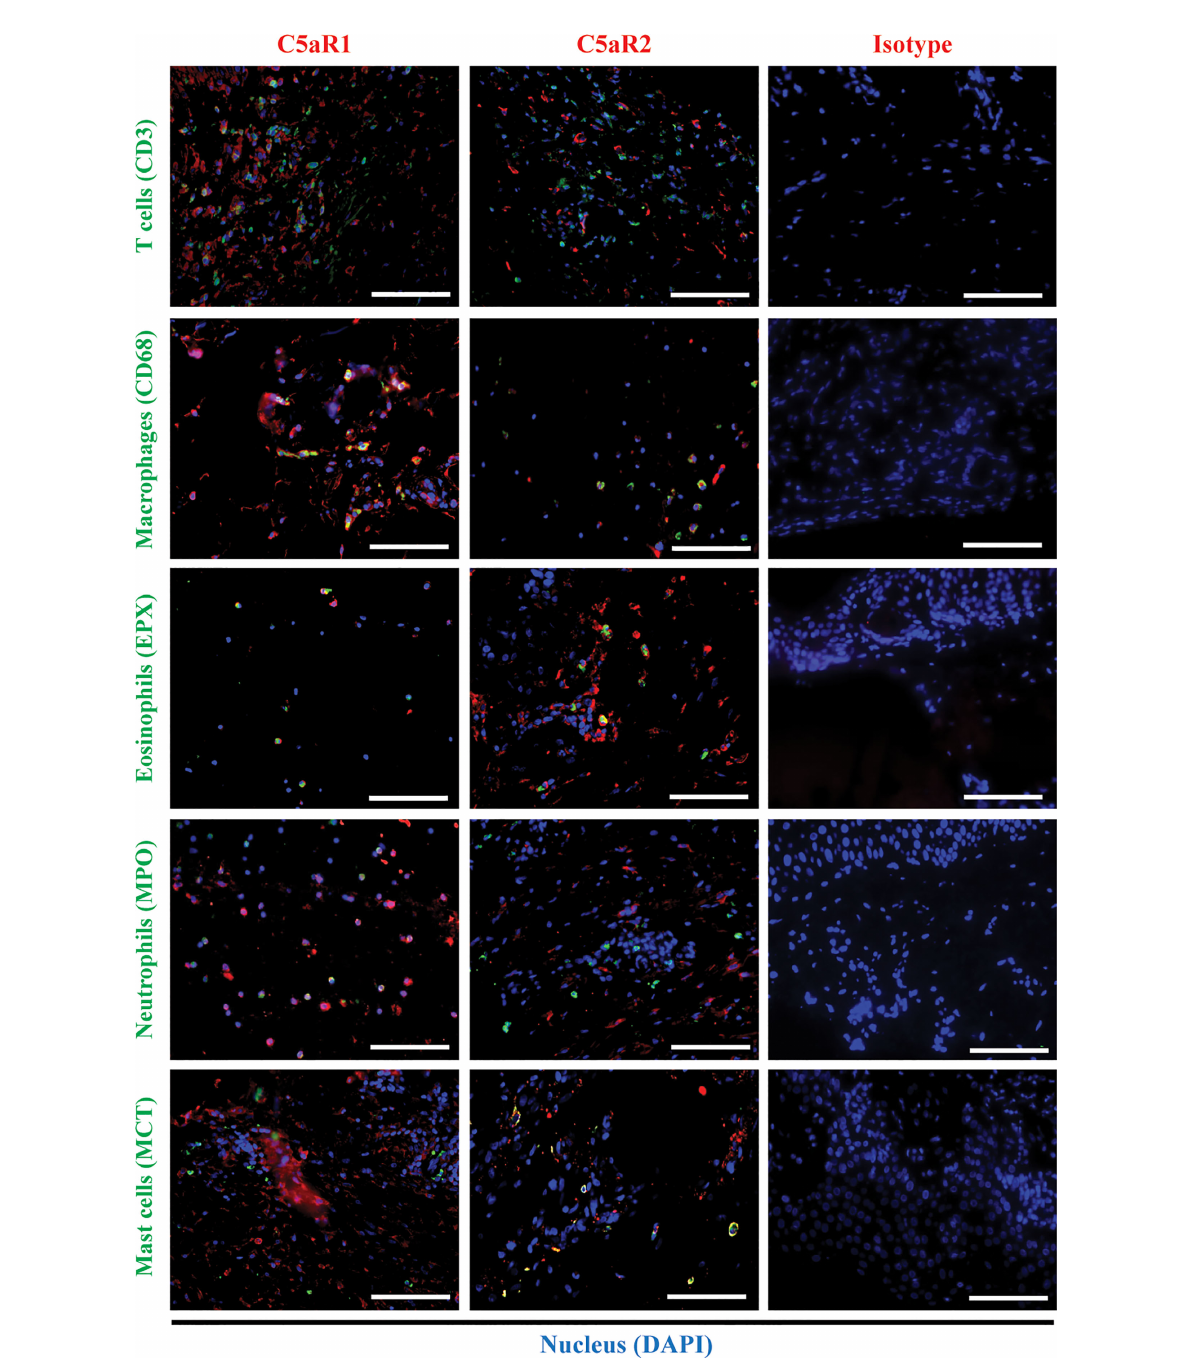
FIGURE 2 Double immuno fl uorescence (IF) staining revealed the cellular sources of C5aR1 and C5aR2 in early bullous pemphigoid (BP) skin lesions. IF staining on perilesional skin of BP patients (n=9) shows colocalization of C5aR1 (red) or C5aR2 (red) and cellular markers (green) on in fi ltrating T cells (CD3), macrophages (CD68), eosinophils (eosinophil peroxidase, EPX), neutrophils (myeloperoxidase, MPO), and mast cells (mast cell tryptase, MCT). Double positive cells appear in yellow. Stainings with isotype antibodies (Isotype) served as controls. DAPI staining of nuclei is shown in blue. Scale bars, 100